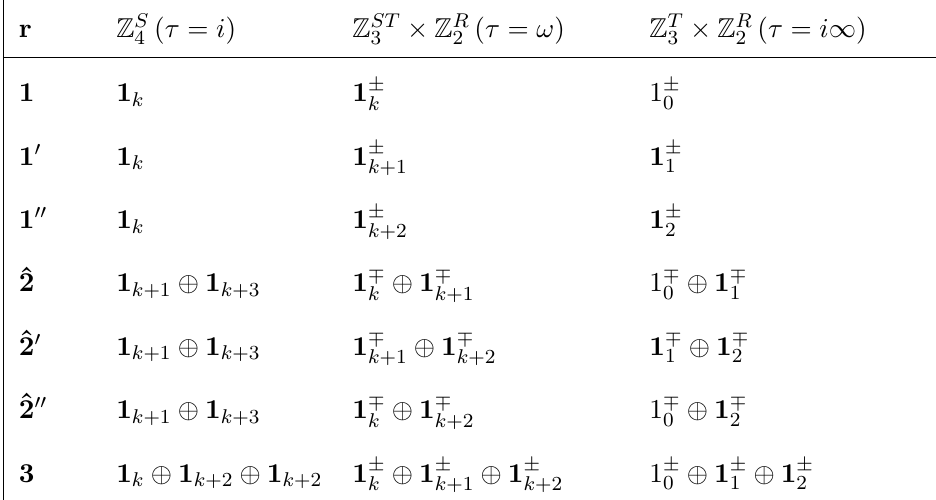
Table 7. Decompositions of ‘weighted’ ( r , k ) multiplets of Γ 0 symmetry groups. Irrep subscripts should be understood modulo n , where n = 4 , 3 in the first and second columns, respectively. Upper (lower) signs correspond to even (odd) values of k